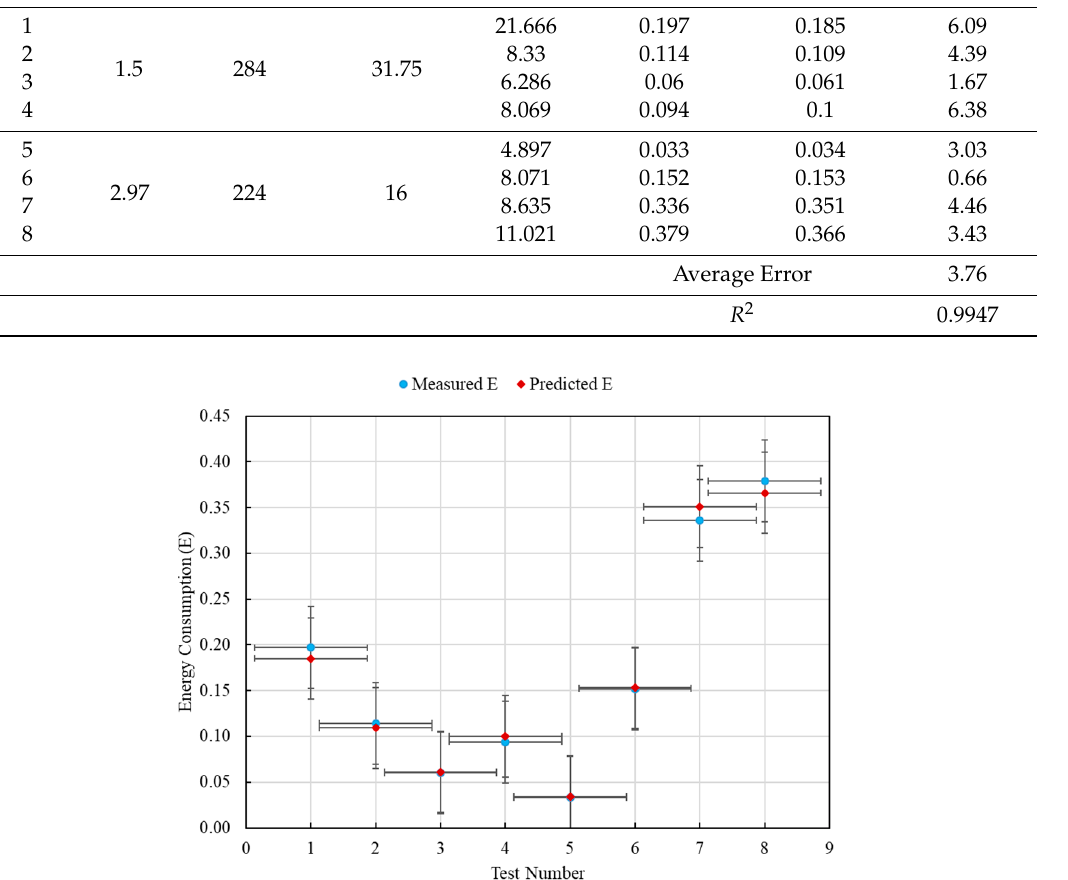
Table 2. The ANFIS predicted powers versus the measured energy consumed by the jaw crusher. Test No.